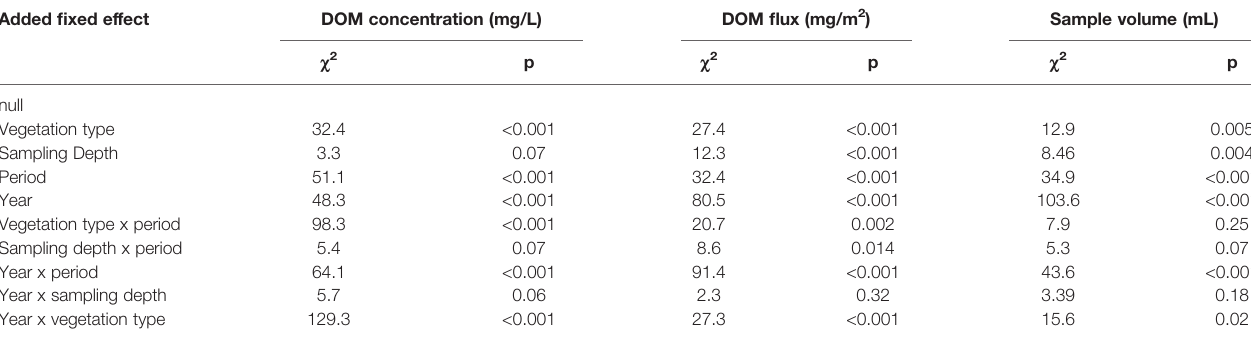
TABLE 1 | Summary of the linear mixed models testing for factors signi fi cantly in fl uencing DOM concentration, DOM fl ux and sample volume. Added fi xed effect